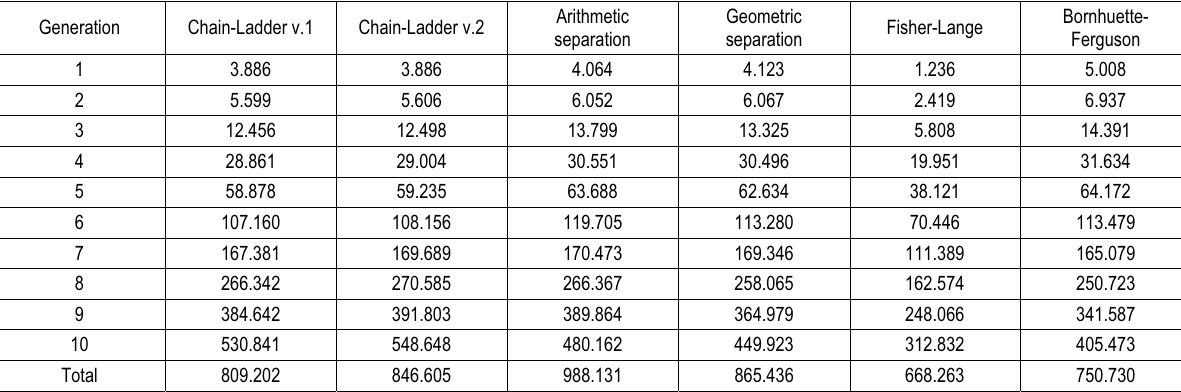
Table 7. Mean square error method of backward calculated random development factors